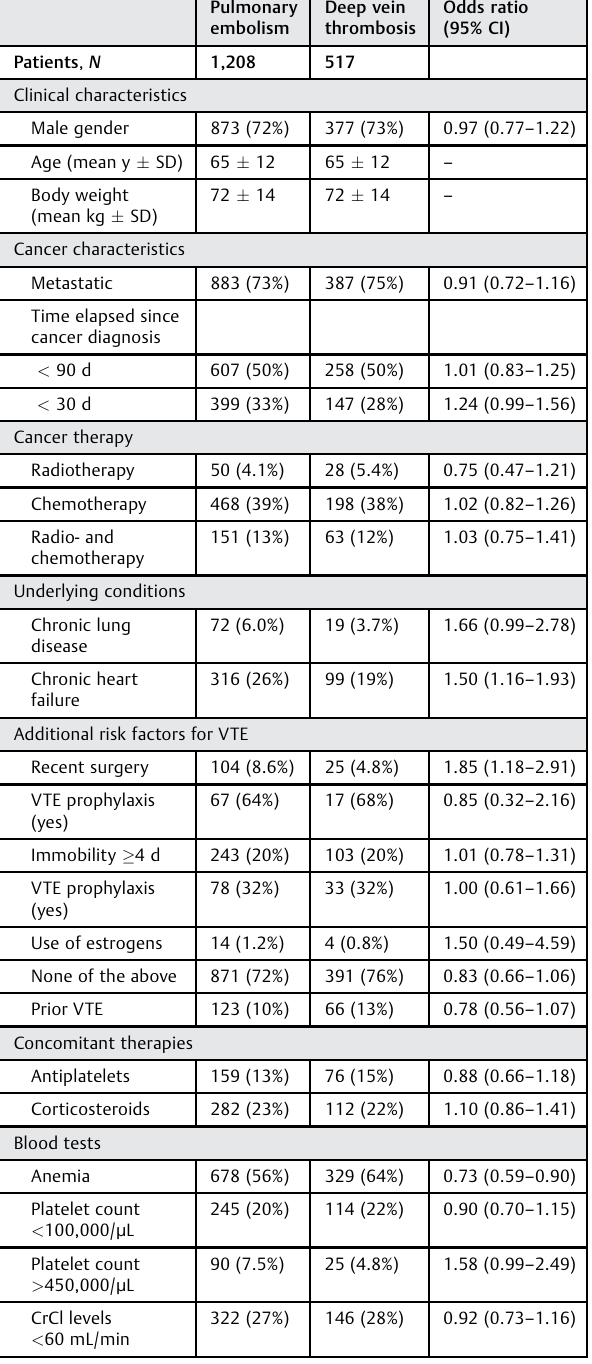
Table 1 Clinical characteristics of the patients, according to initial VTE